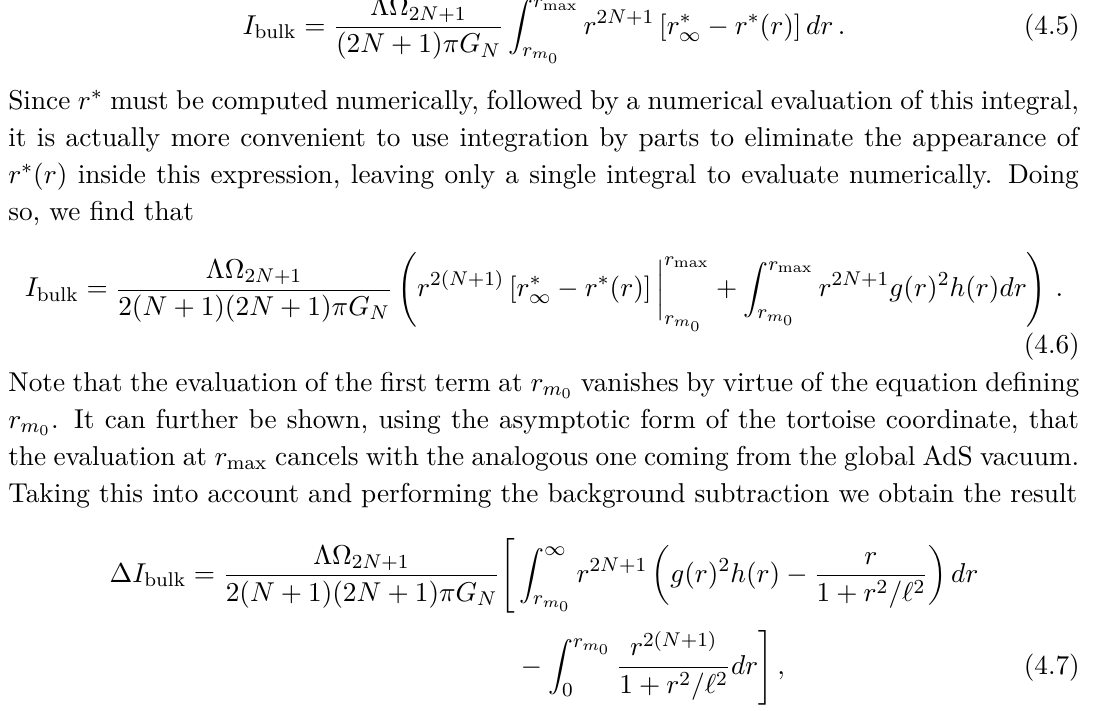
Figure 5. A plot showing the value of r m curves correspond to r + /‘ = 5 , 10 , 50 , 100 in order from bottom to